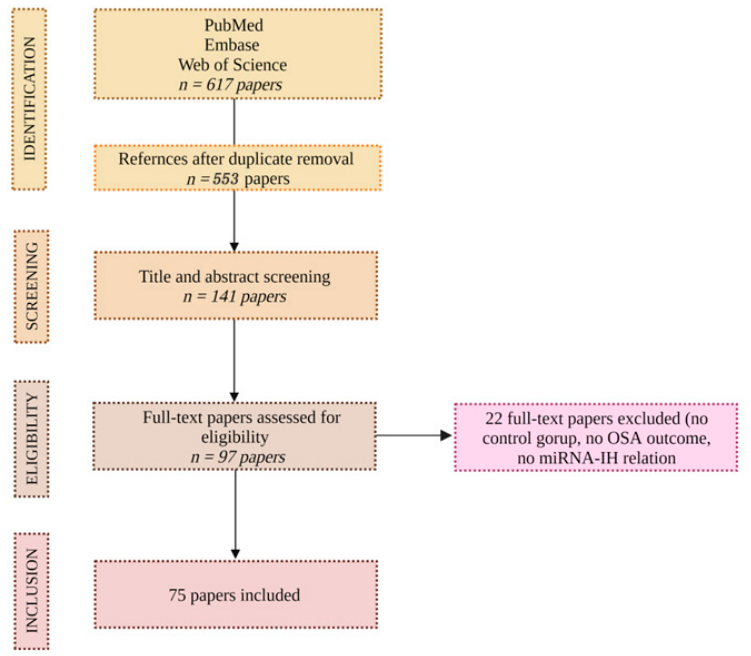
Figure 1. CONSORT